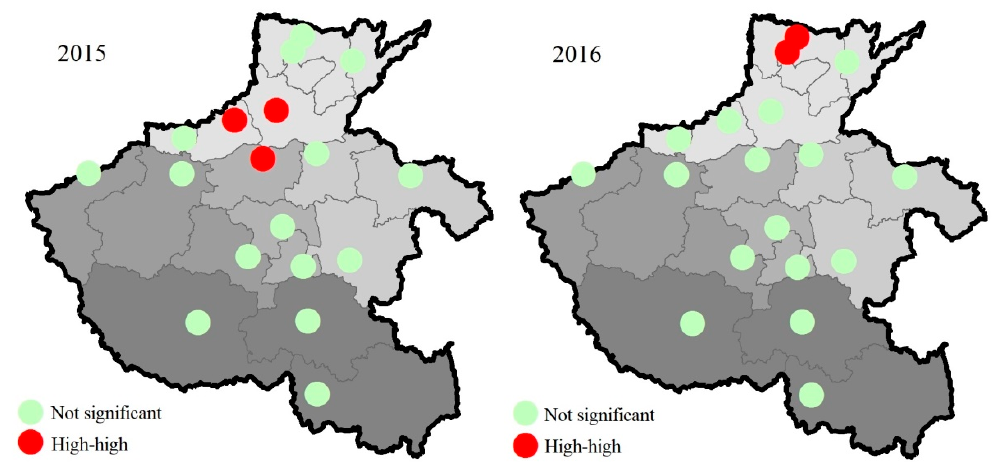
Figure 6. Local spatial autocorrelation model of the mean NAQI in 2015–2016. The grey color changes from light to deep denote north, east, center, west and south Henan Province, respectively.